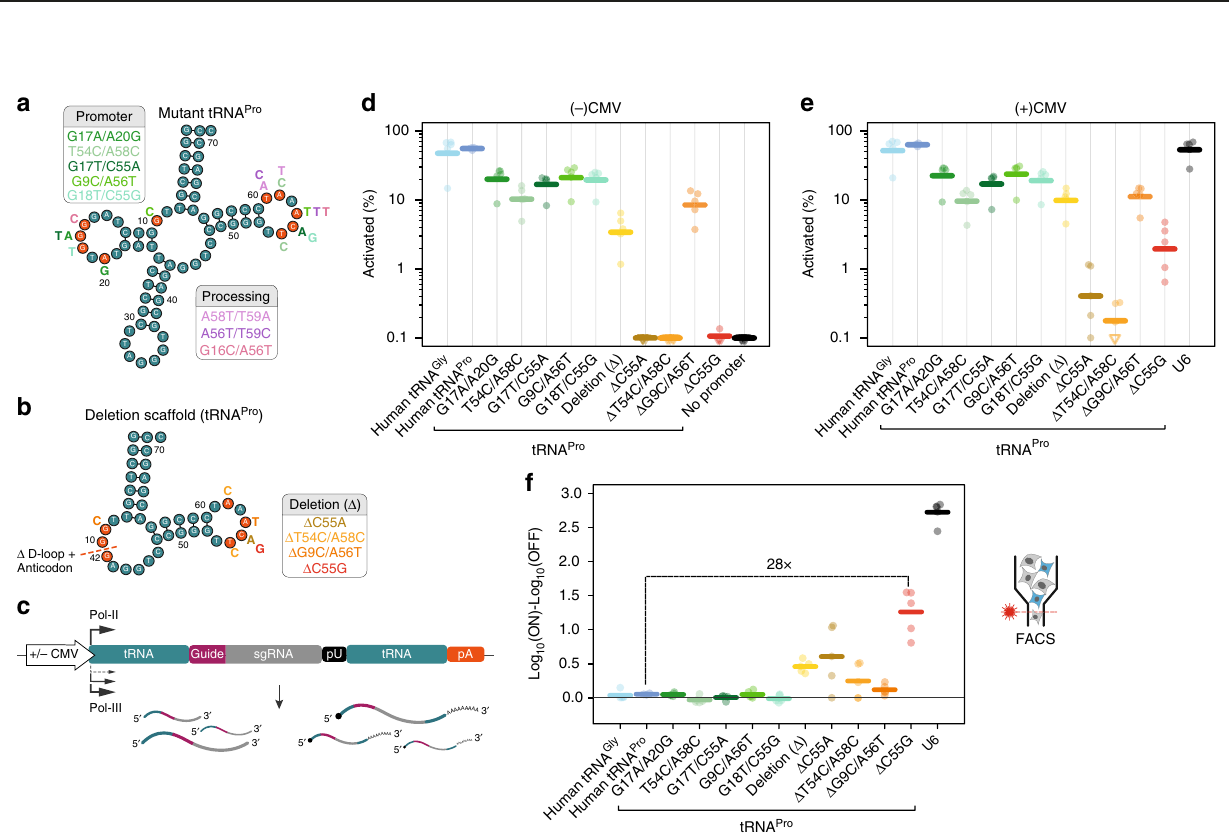
Fig. 3 Combinatorial tRNA deletions and point mutations improve the ON − OFF speci fi city of Pol-II gRNA expression. a , b tRNA diagrams with mutation pairs predicted from sequencing data to affect 3 ′ processing only (pink tones), or promoter activity with minimal effect on processing (green/orange/red tones) (left panel). Selected pairs of mutations are shown as letters next to the wild-type ( a ) and Δ tRNA Pro ( b ) scaffolds. c Constructs used to test ON/ OFF ratios of each variant combination in the presence and absence of a Pol-II promoter. d , e Percentage reporter ECFP + cells within transfected cells with ( d ) and without ( e ) a CMV promoter. Thick lines indicate geometric mean values. Each point represents an independent experiment ( n = 4 – 5). f Log 10 (% ECFP + cells) in the ON condition compared to OFF condition for each tRNA and U6 (relative to no promoter) (thick lines = mean values; n = 3 – 5 independent experiments). The U6 and no promoter control are shared with Fig. 1 and Supplementary Fig. 4d. Δ C55G had a >99.9% probability of decreased activity compared to U6, but a 99% probability of increase compared to parental tRNA (paired BEST tests). Source data are provided as